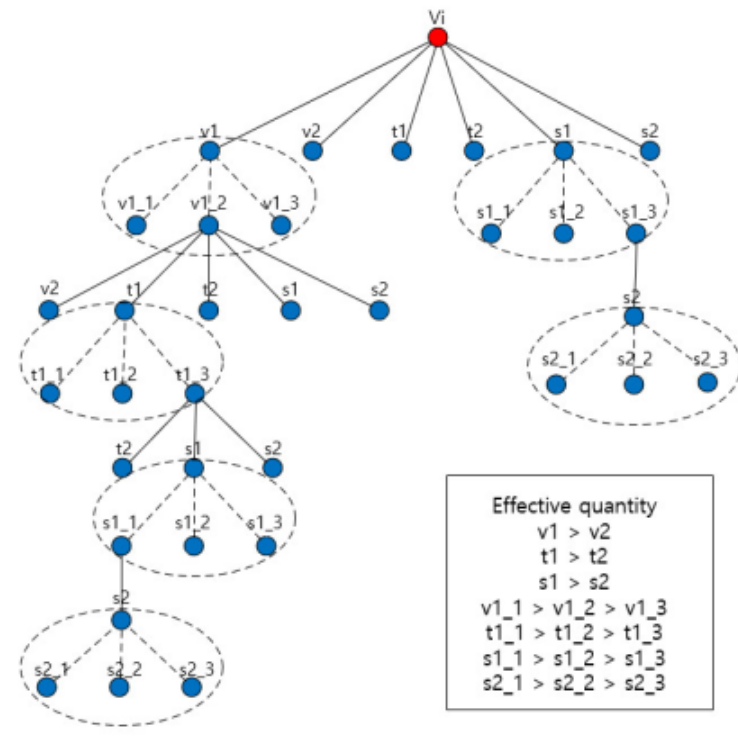
Figure 2. State-space model of voltage